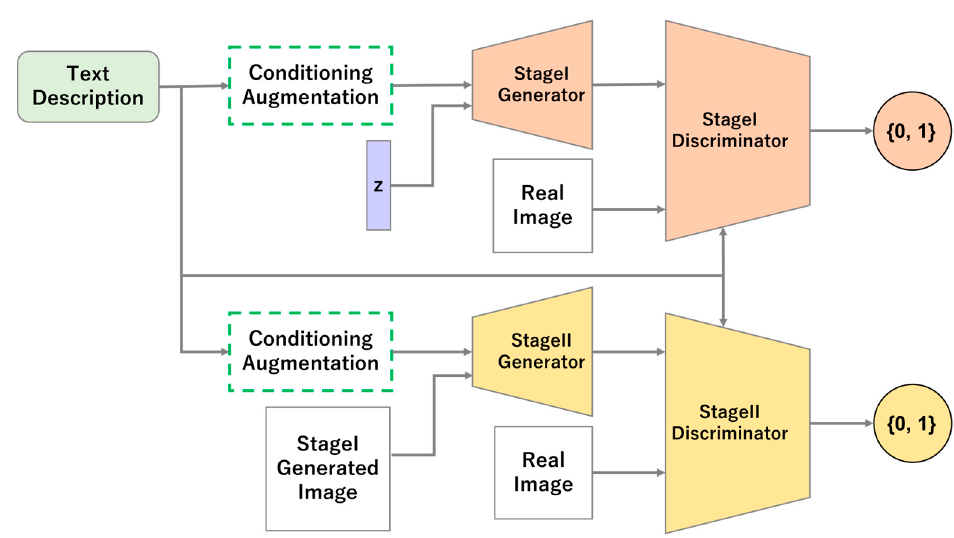
Figure 1. Overview of the Stacked Generative Adversarial Networks model.